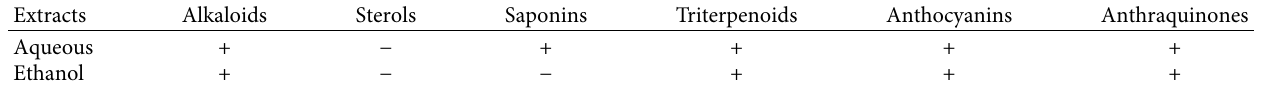
Table 3: Phytochemical screening of L. lanceolata extracts.